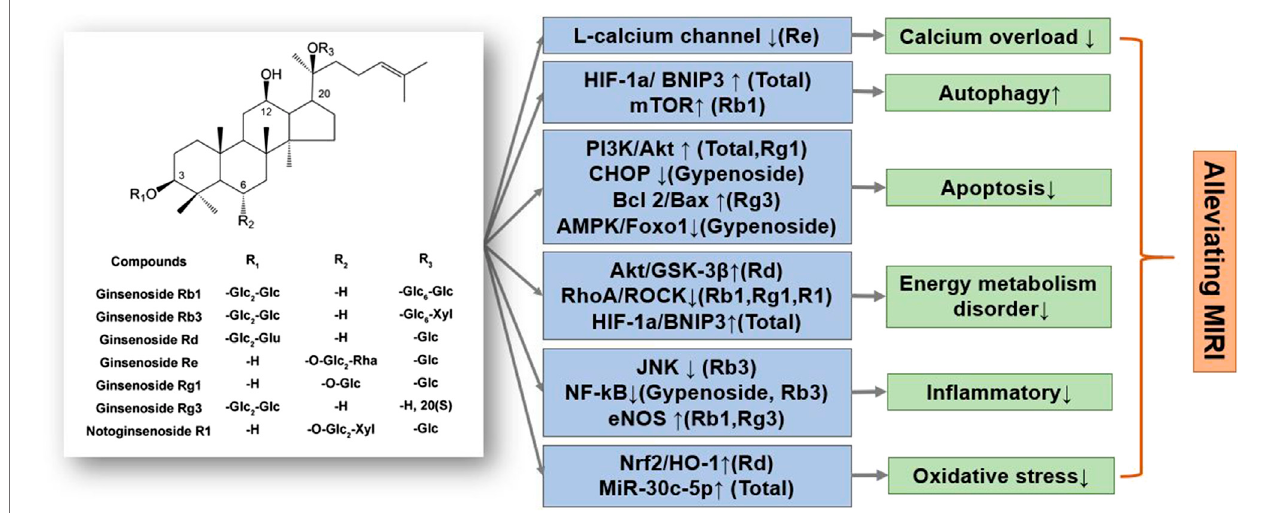
FIGURE 2 | A schematic representation of mechanisms of saponins from Ginseng exerted cardioprotective effects in MIRI. Glc, glucose; Rha, rhamnose; Xyl, xylopyranose. ↑ means activate relevant pathways. ↓ means suppress relevant pathways.